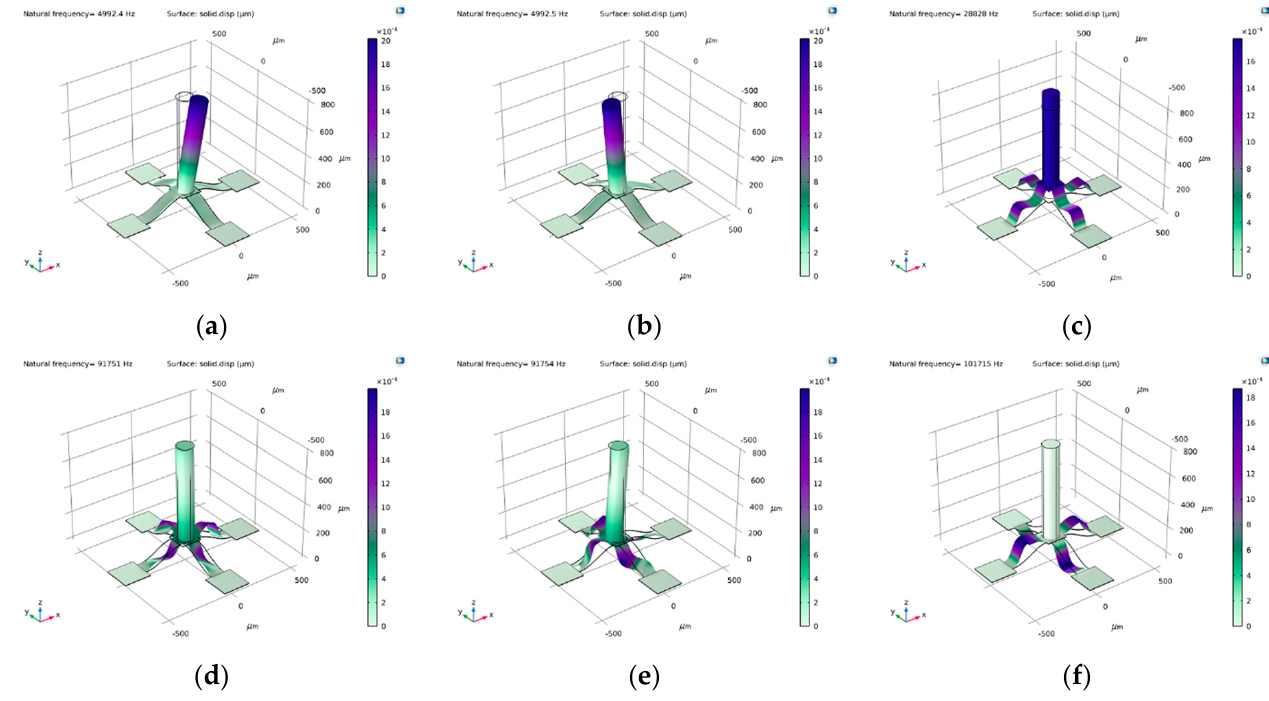
Figure 11. The natural frequency of microstructure: ( a ) first natural frequency; ( b ) second natural frequency; ( c ) third natural frequency; ( d ) fourth natural frequency; ( e ) fifth natural frequency; ( f ) sixth natural frequency.